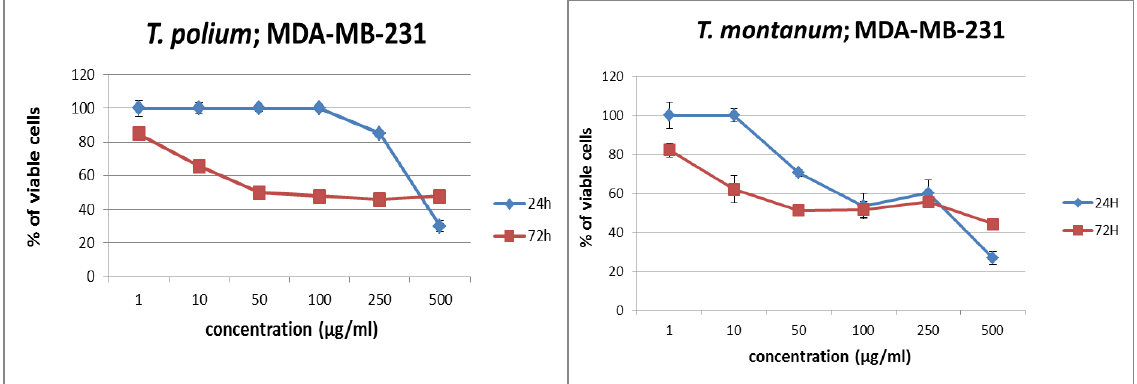
Figure 1. Cytotoxic activity of the methanol extracts from T. polium and T. montanum on MDA-MB-231 cell lines. Results are expressed as means ± SE for three independent determinations.